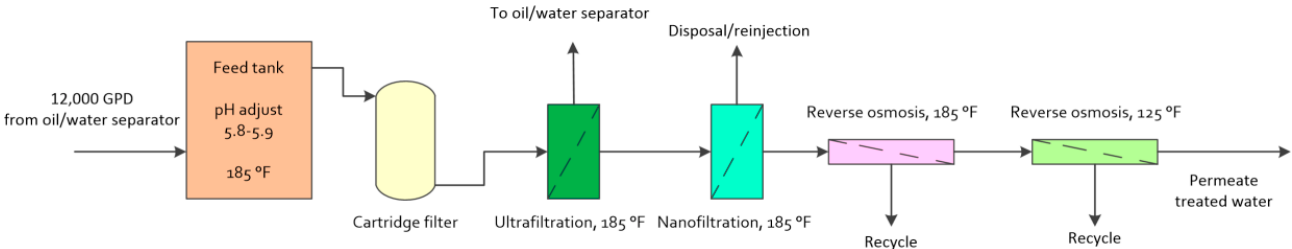
Figure 1. Schematic flow diagram of the GE pilot scale produced water treatment system (modified after [16,131,145]).